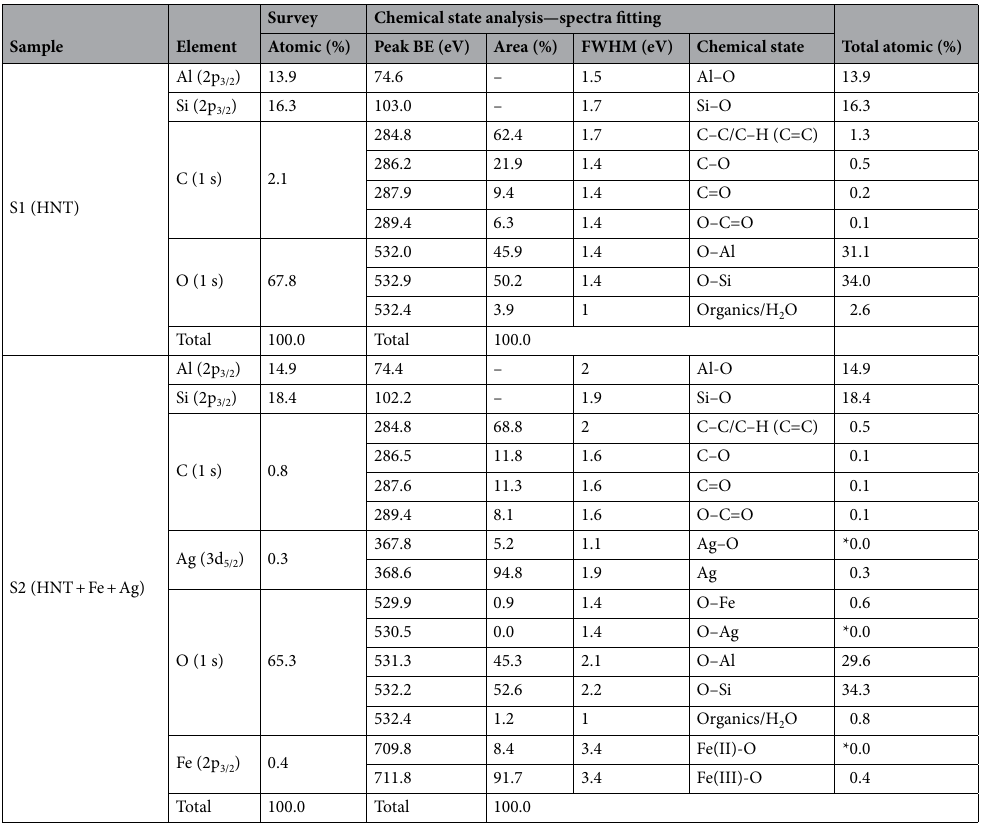
Table 2. Chemical state analysis and quantification for HNT and Surface Treated HNT. *0.0 means the value is below